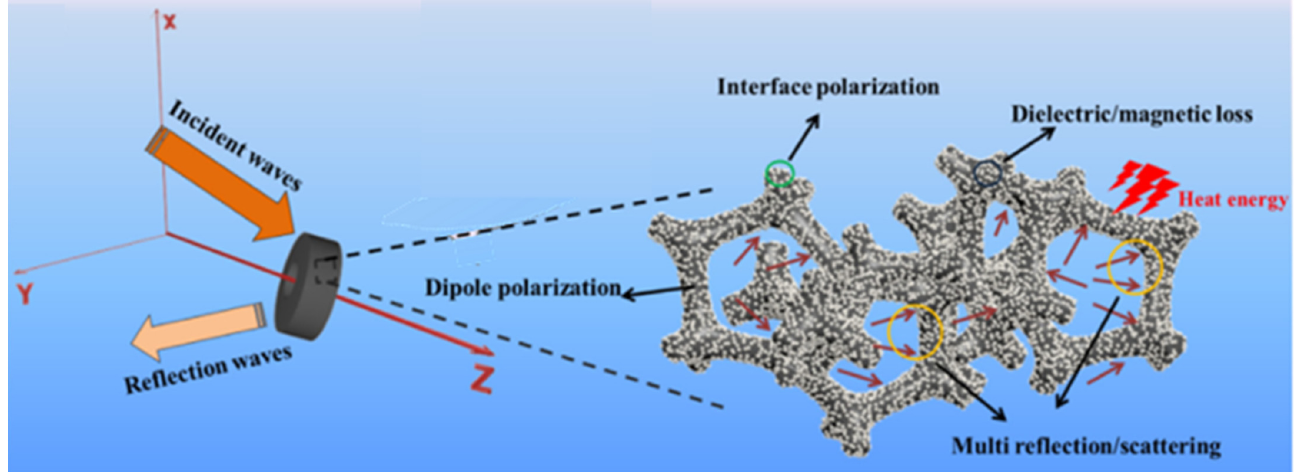
Figure 9. Schematic illustration for the electromagnetic wave absorption mechanism of Fe 3 O 4 /C samples. Reproduced with permission from Ref. [65], Copyright 2019, Elsevier. samples. Reproduced with permission from Ref. [65], Copyright 2019, Table 4. The electromagnetic absorption performance of blended Fe-based composites.